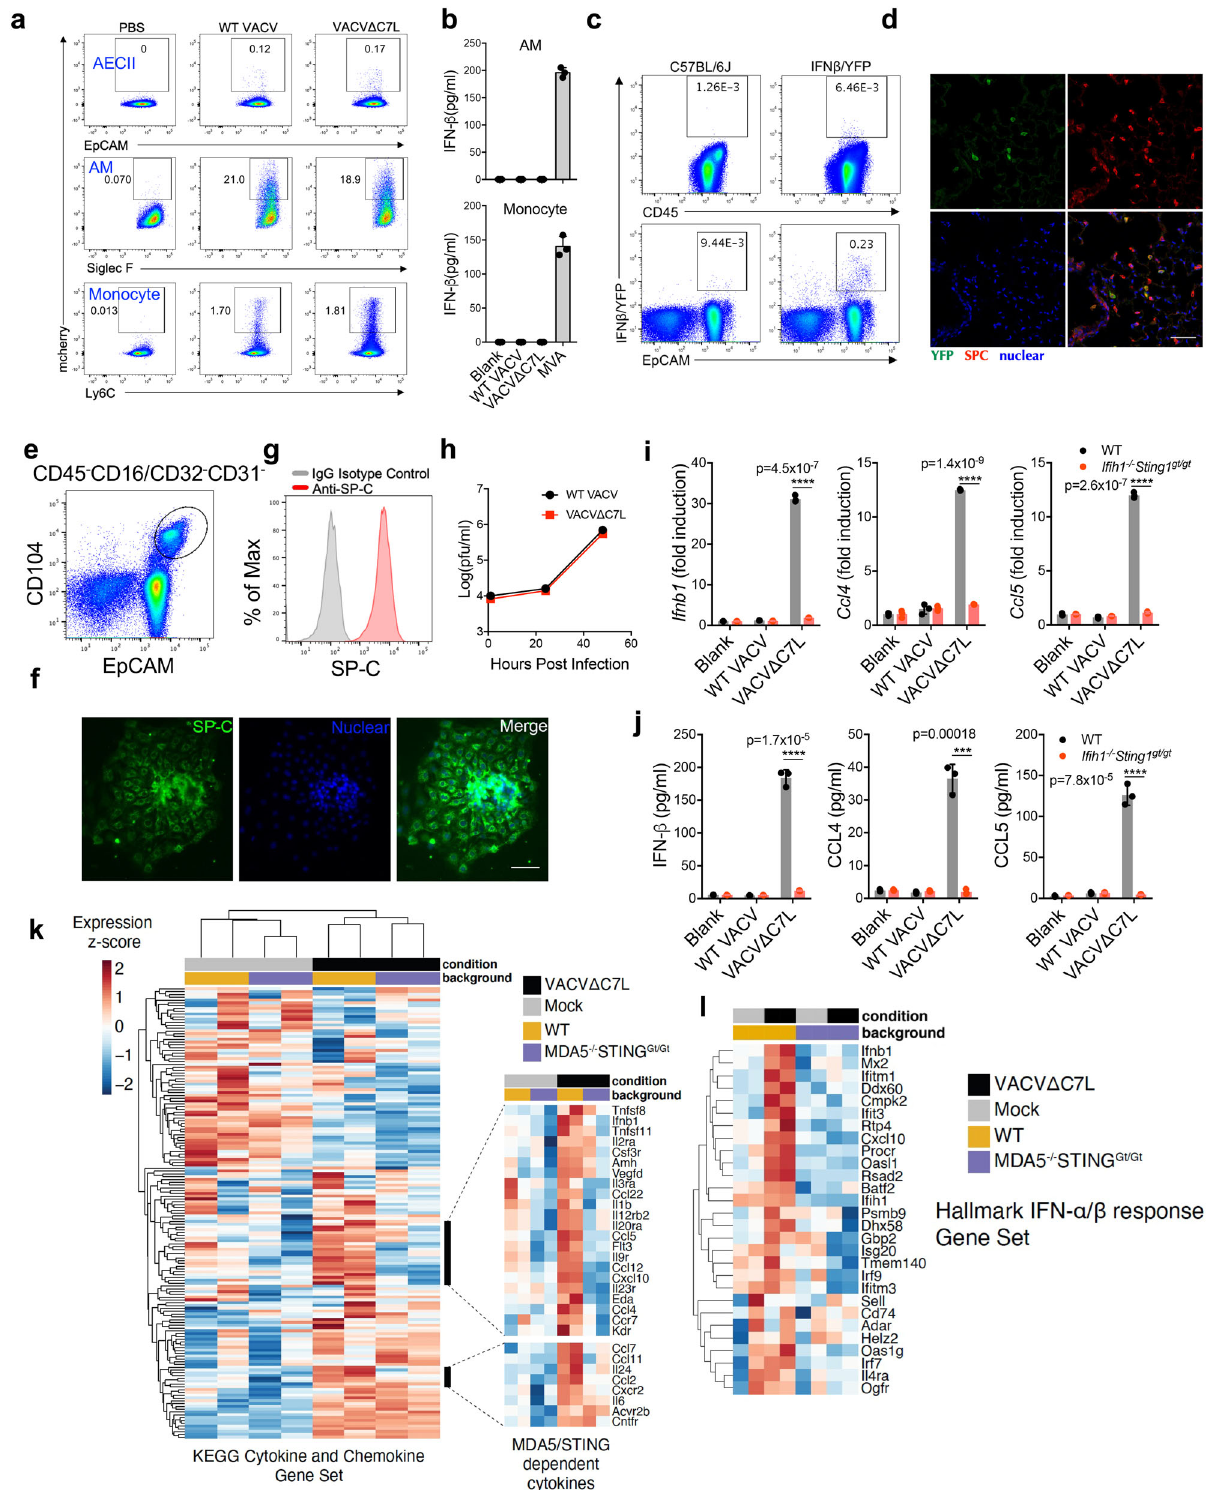
in vitro did not result in IFN- β production. Modi fi ed vaccinia virus Ankara (MVA), derived from the vaccinia Ankara strain through more than 500 passages in chicken embryo fi broblasts (CEFs) and lacking many genes involved in immune regulation, was used as a positive control 20 . MVA is non-replicative in